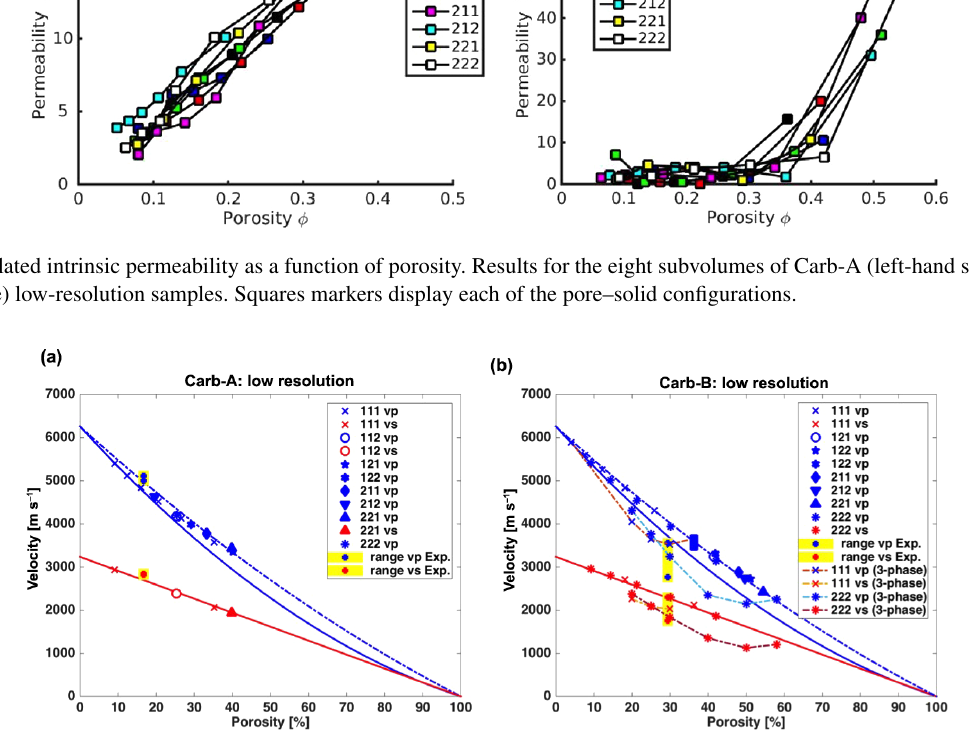
Figure 10. Effective P -wave and S -wave velocities (red and blue dots, respectively) for simulations based on a two-phase segmentation. The results were obtained for subvolumes of the low-resolution images of Carb-A (left-hand side) and of Carb-B (right-hand side). The blue and red lines are the velocity trends given by Eqs. (4) and (5); the blue dashed/dotted line is the trend given by Eq. (6). The experimental results (interval from 0 to 30MPa confining pressure) are illustrated with crosses connected with yellow bars for comparison. The green dots display the results of the multiphase simulations (only performed for Carb-B and for P waves). For details please refer to the